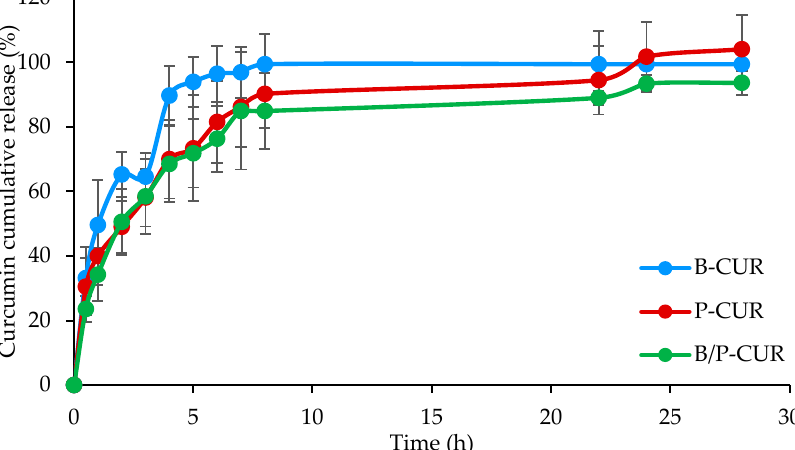
Figure 7. In vitro cumulative release profiles of curcumin from B-CUR, P-CUR, and B/P-CUR hydrogels (mean values ± s.d.; n = 3). ANOVA one-way; Scheffe’s test ( p ≤ 0.05): B-CUR 2 h vs. P-CUR 2 h.